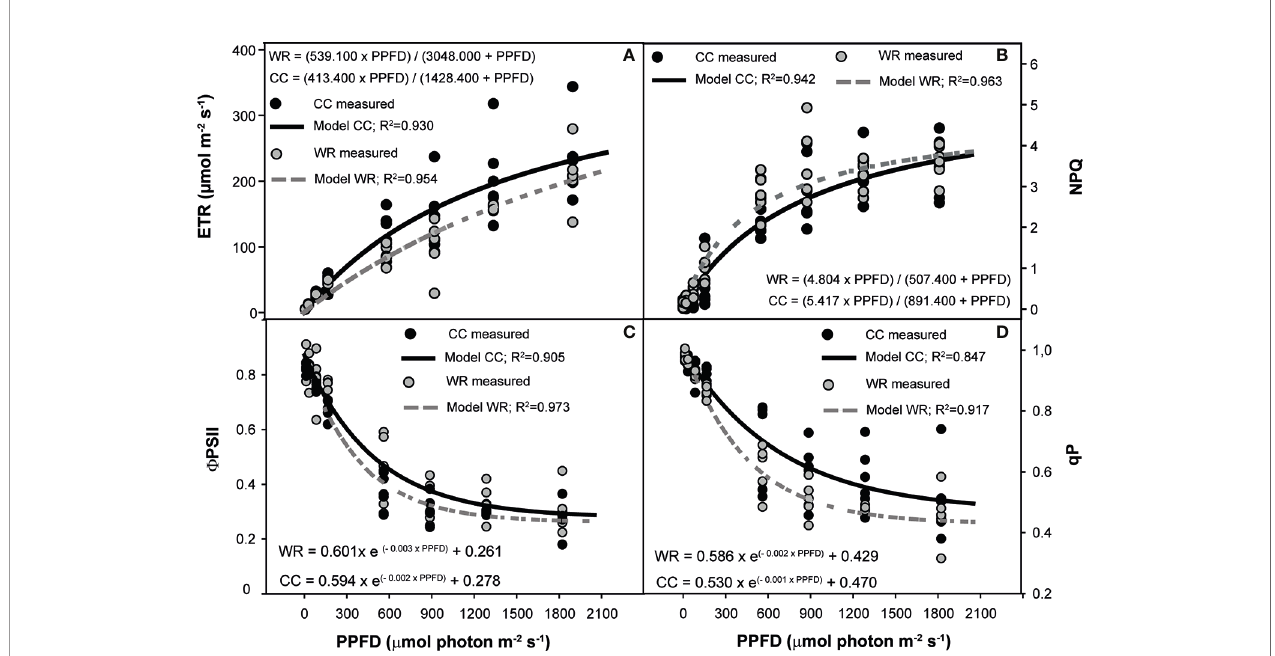
FIGURE 5 | Effect of increasing photosynthetic photon fl ux density (PPFD, µmol photon m -2 s -1 ) on electron transport rate (ETR, µmol m -2 s -1 ) (A) , non- photochemical quenching (NPQ) (B) , photochemical ef fi ciency of PSII ( f PSII) (C), and photochemical quenching (qP) (D) of Persea lingue plants from Cayumanque under the water restriction (WR) and container capacity (CC) treatments. Dots indicate measured data (CC in black, WR in gray) and lines indicate modelled data (CC in continuous black line, WR in dashed gray line). Adjusted model for CC and WR treatments for each variable and population are shown on each panel.